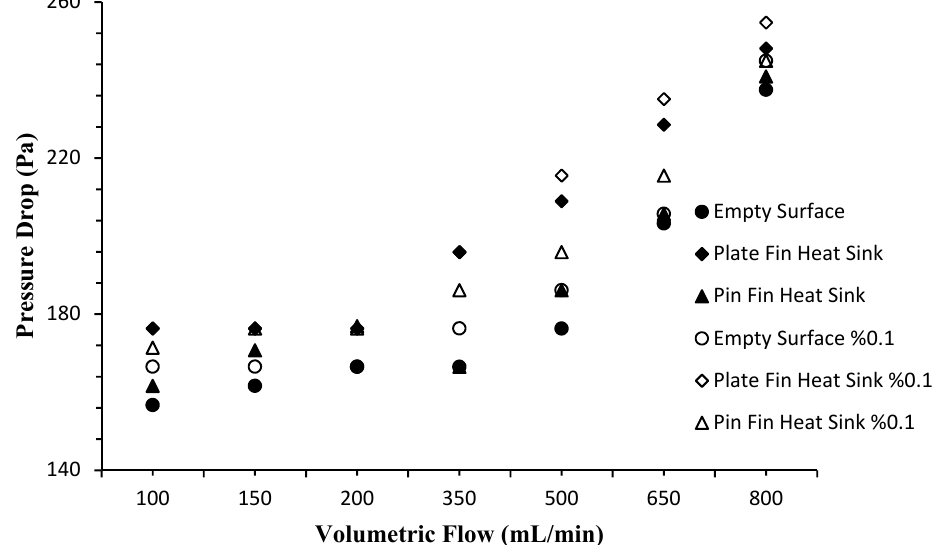
Figure 5. Pressure drop inside the water block for base fluid and nanofluid in different surfaces.